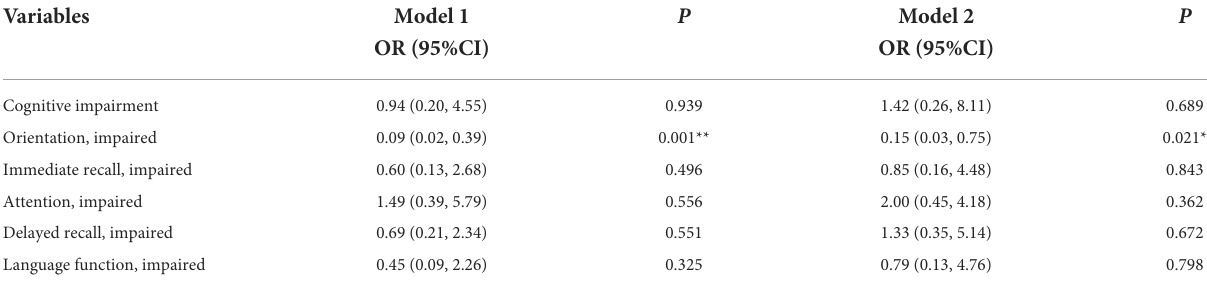
TABLE 3 Associations between walking speed and cognitive impairment and impaired cognitive domain function in women by binary logistic regression analysis.